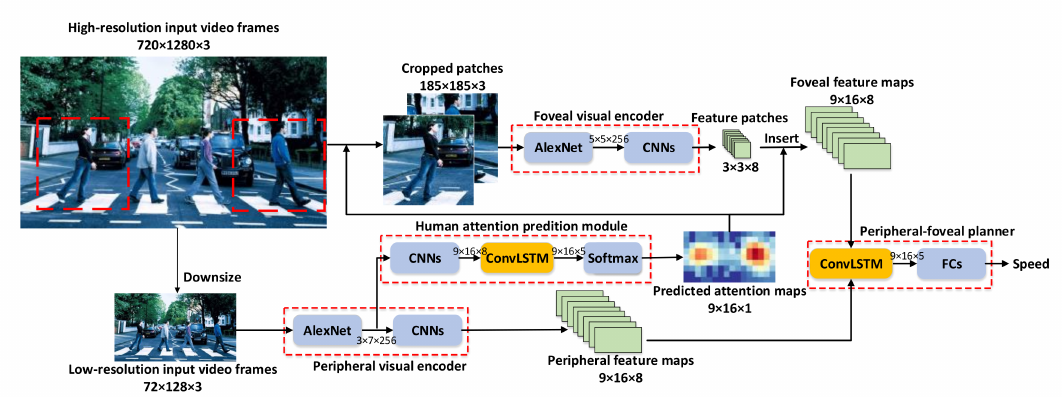
Figure 11. Overview of the peripheral fovea multi-resolution driving